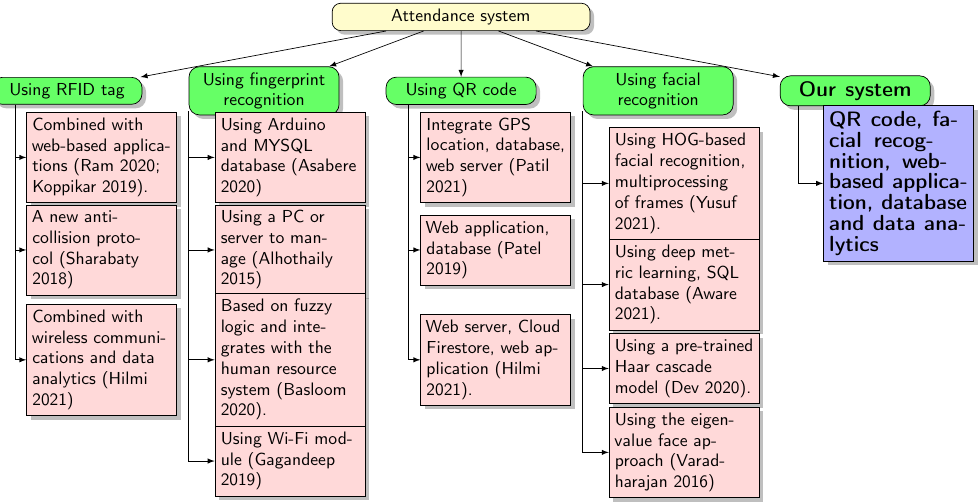
Figure 1. A classification of attendance system [10,13–17,19–22,25–28].